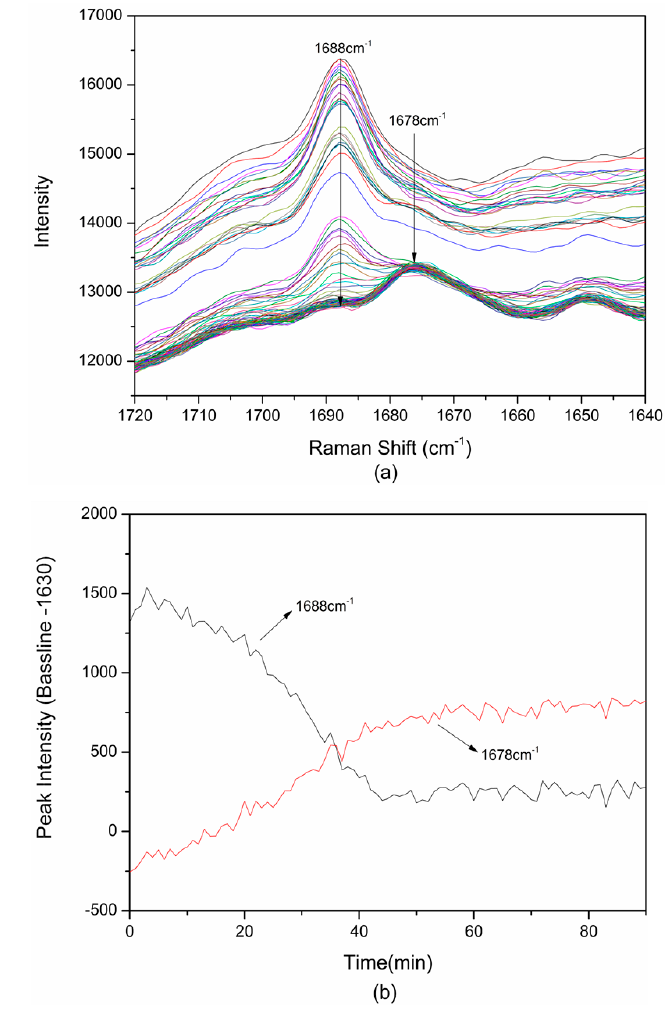
Figure 5. ( a ) The variation of Raman spectra at 1640–1720 cm − 1 ; ( b ) The change of relative peak intensity of 1678/1688 cm − 1 in TP-BA cocrystal formation in slurry crystallization at 298.15 K. The information about the time interval of the Raman spectra are listed in Table S1.